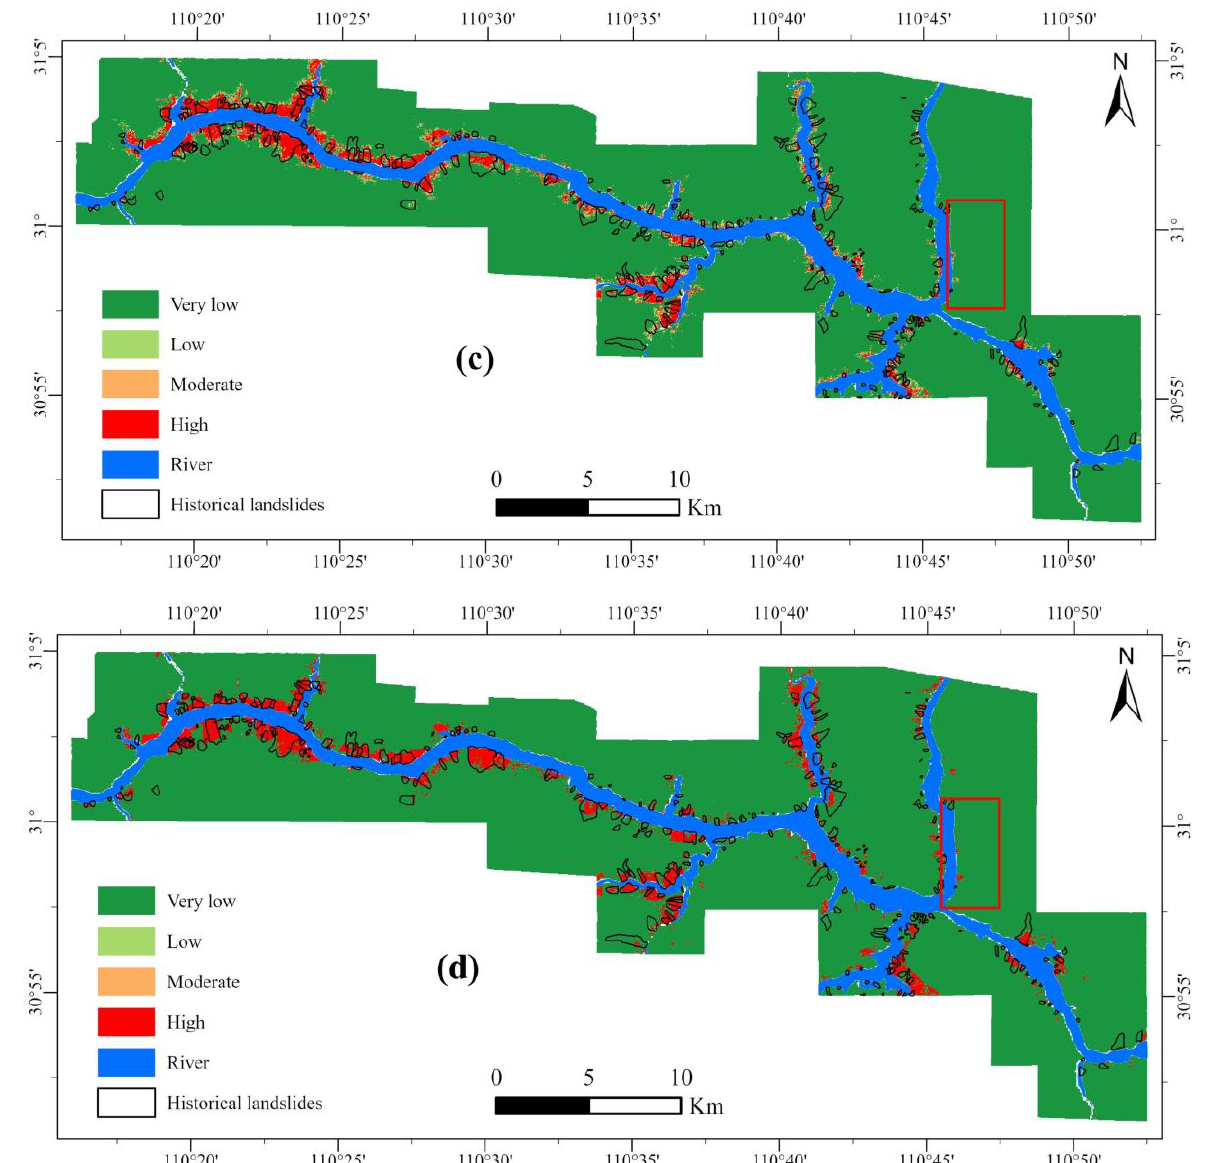
Figure 13. LSA results under the class balanced strategy: ( a ) result of LR, ( b ) result of RF, ( c ) result of DFCNN, ( d ) result of LSTM.